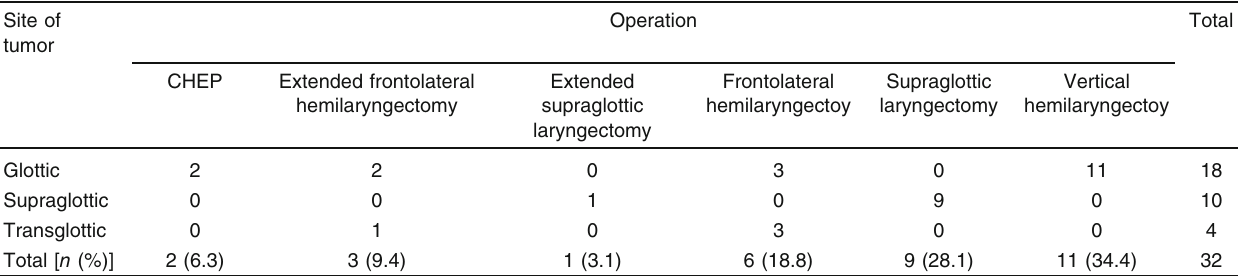
Table 4 Site of tumor and type of operation in the study group Site of